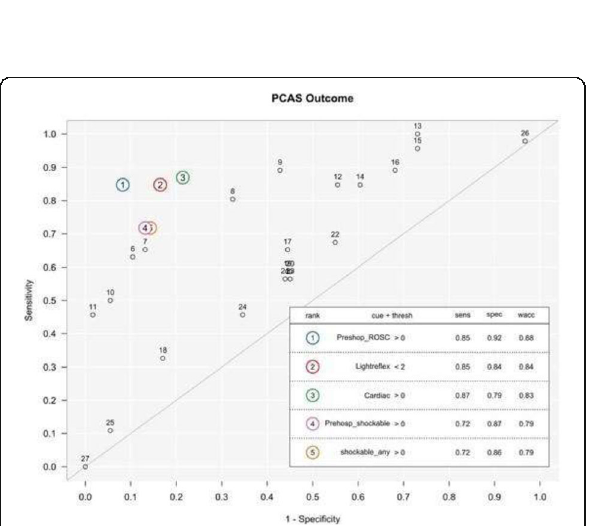
Fig. 2 (abstract 0307). Testing FFT for Prediction of Neurologic